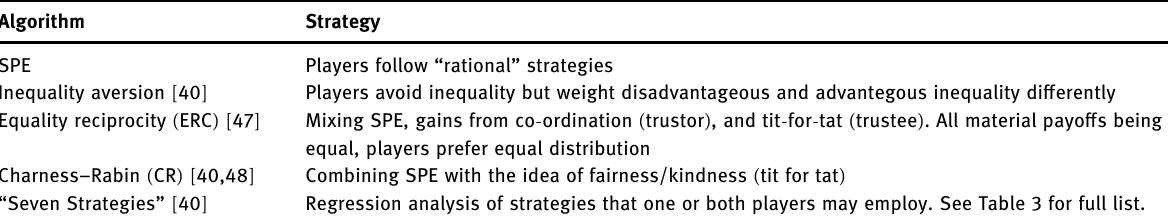
Table 2: Previously proposed strategies of trusting and trust ful fi llment Algorithm Strategy SPE Players follow “ rational ” strategies Inequality aversion [ 40 ]